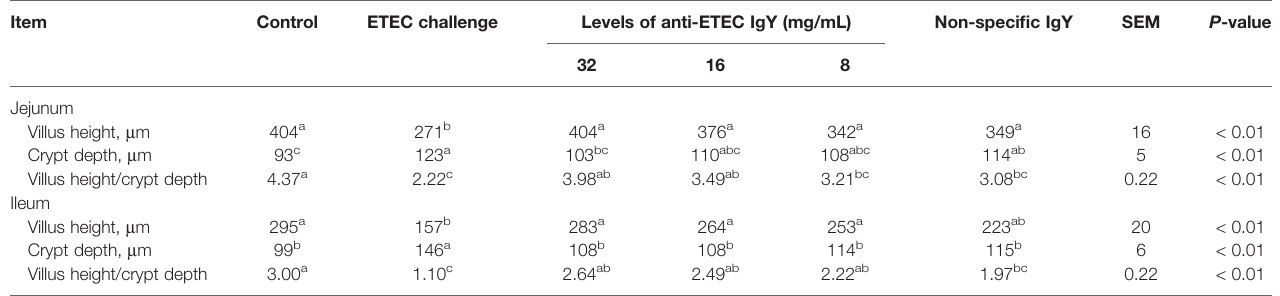
TABLE 4 | Effect of IgY on the morphology of jejunum and ileum in ETEC K88 infected mice. Item Control ETEC challenge Levels of anti-ETEC IgY (mg/mL) Non-speci fi c IgY SEM P